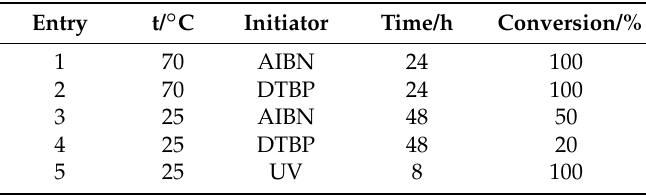
Table 4. Conditions used for the synthesis of polymer 1